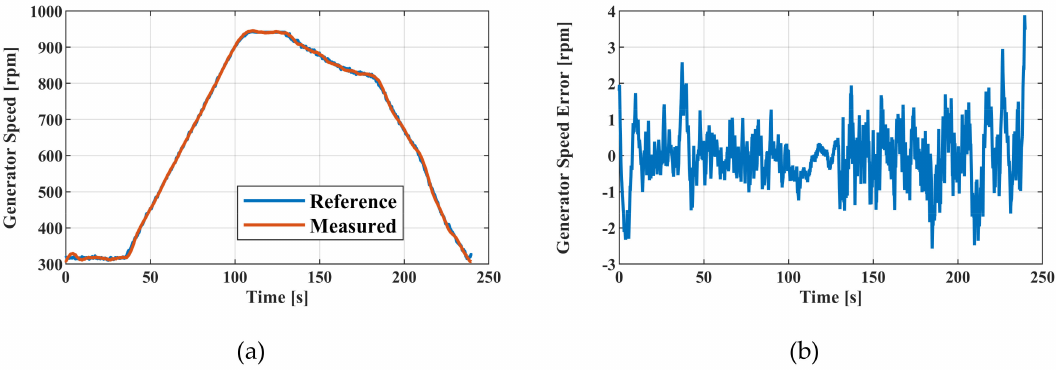
Figure 14. ABPMSG rotor speed: ( a ) speed reference and measured rotor speed; ( b ) absolute speed tracking